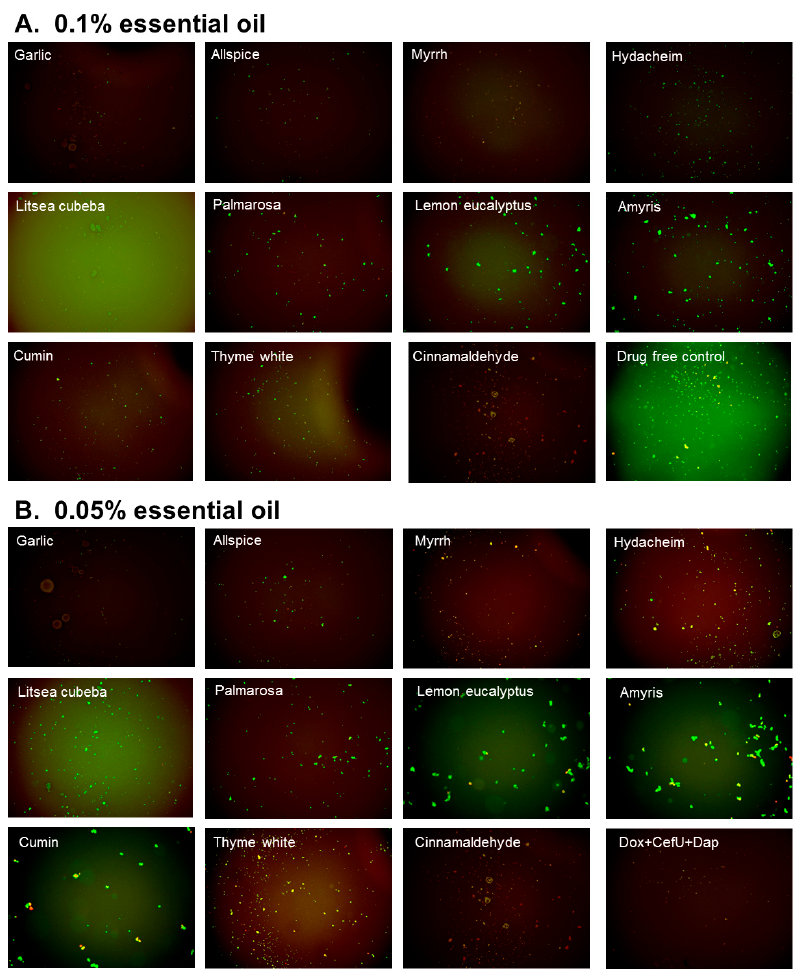
Figure 3. Effect of active essential oils on stationary phase B. burgdorferi . A 1 mL B. burgdorferi stationary phase culture (seven-day old) was treated with 0.1% ( A ) or 0.05% ( B ) essential oils (labeled on the image) in 1.5 mL Eppendorf tubes for 7 days followed by staining with SYBR Green I/PI viability assay and fluorescence microscopy.